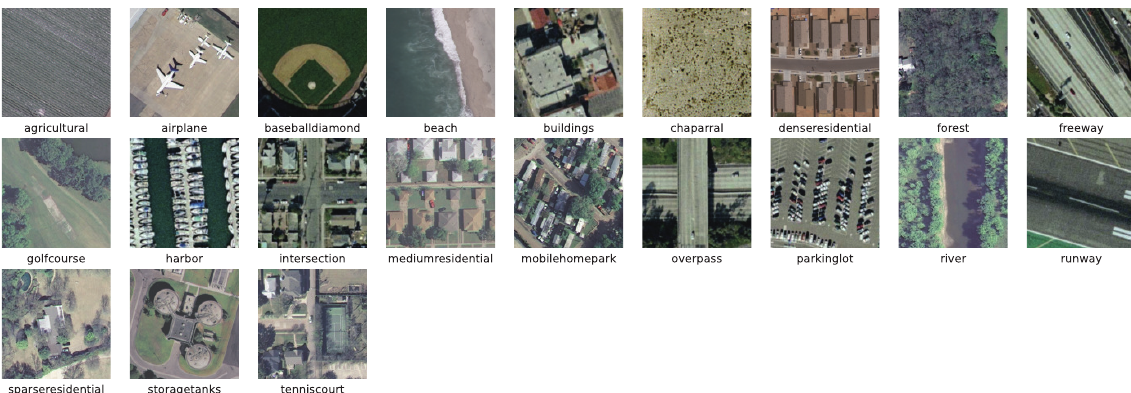
Figure 7. Some samples from the UCM